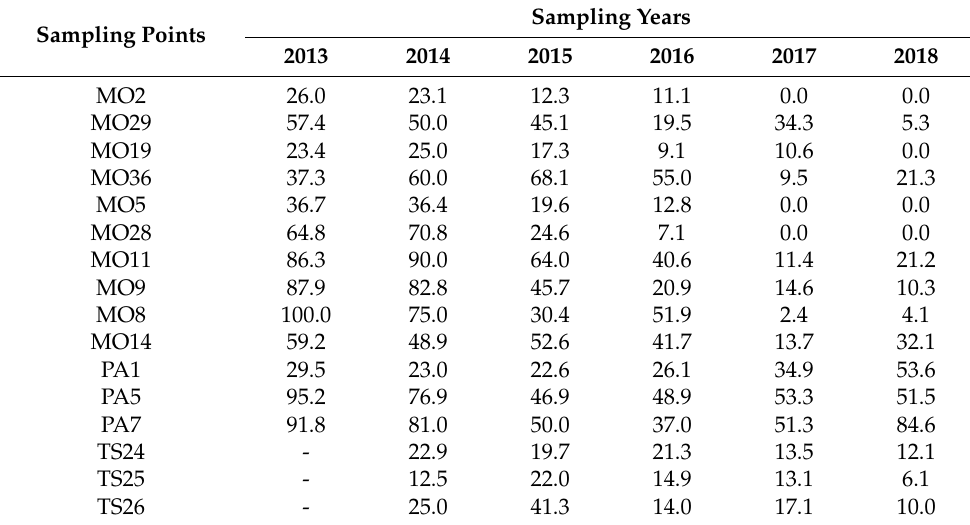
Table 3. Maximum values of percentage infestation [I (%) ] of Abies spp. nodes by P. hellenicus . Sampling